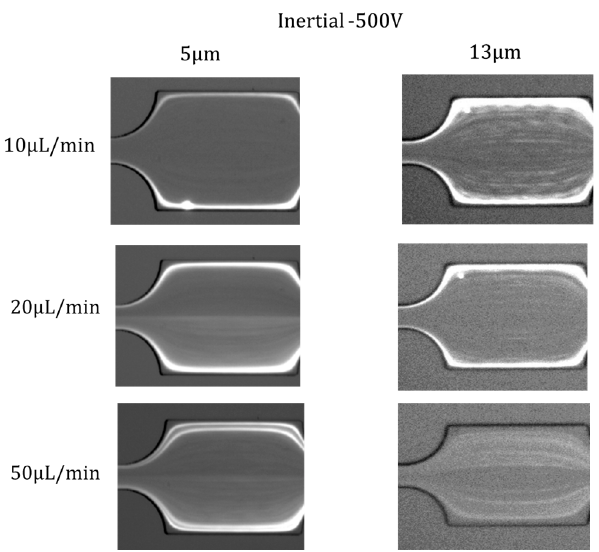
Figure 6. Distribution of 5 μ m and 13 μ m particles in Inertial − 500 V at flow rate 10 μ L/min, 20 μ L/min, and 50 μ L/min.